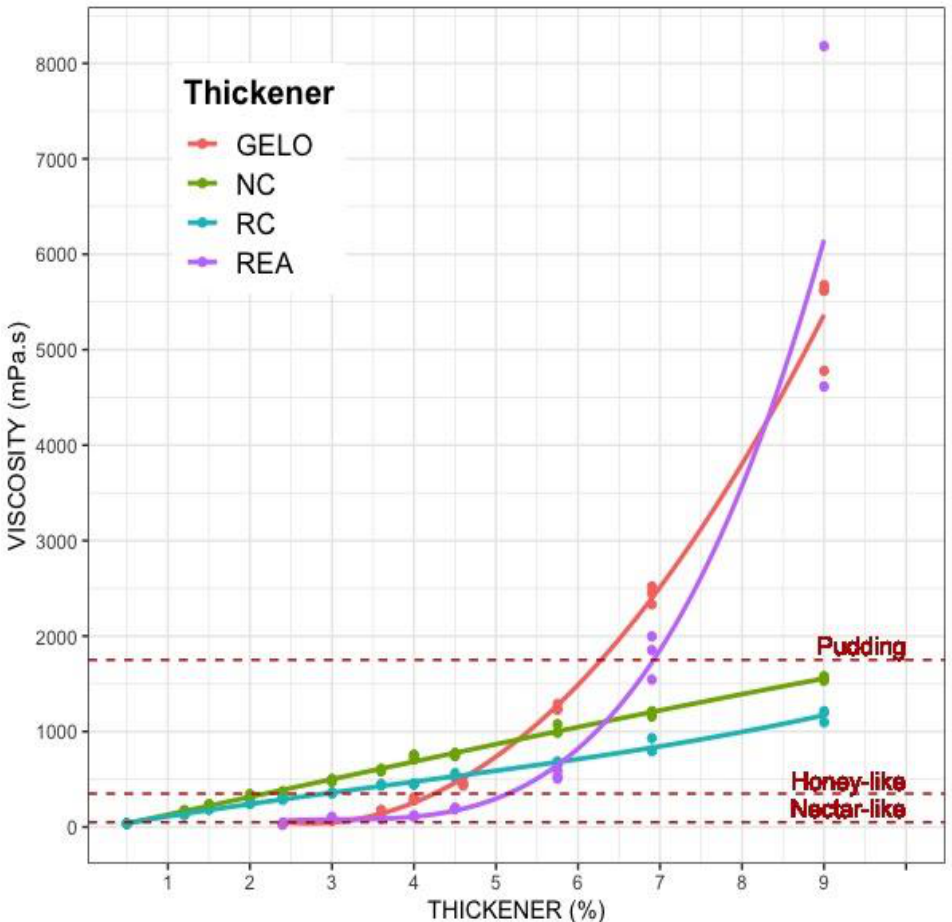
Figure 1. Viscosity of the four thickeners (measured at 50 s − 1 ) as a function of concentration. The viscosities determined at each concentration are shown with dots linked by their regression curve. Starch-based thickener (GELO in orange, REA in purple.), Gum-based thickener (NC in green, RC in blue). Regression curves were obtained for the different thickeners with water as a function of concentration. With these curves, it is possible to calculate the amount of thickener necessary to obtain a given viscosity at 50 s − 1 : NC: V = (180 × X) − 43.08 with a R 2 of 0.995. RC: V = (128 × X ) − 25.44 with a R 2 of 0.989. REA: V = 2920 − (1620 × X) + (219 × X 2 ) with a R 2 of 0.920. GELO: V = 1830 − (1060 × X) + (167 × X 2 ) with a R 2 of 0.998. X represents the concentration of thickener (in